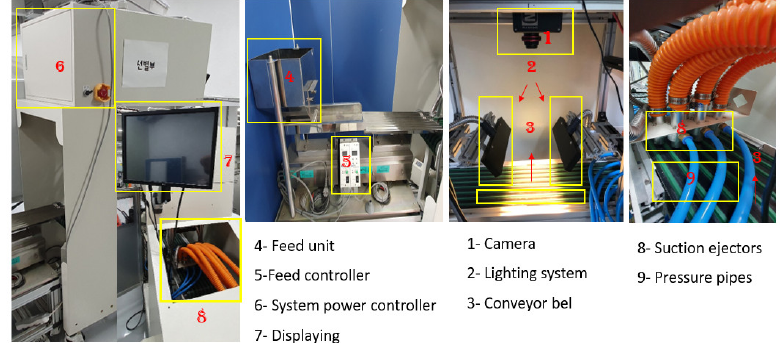
Figure 1. The hyperspectral imaging prototype used for collecting data. Appl. Sci. 2020 , 10 , x FOR PEER REVIEW